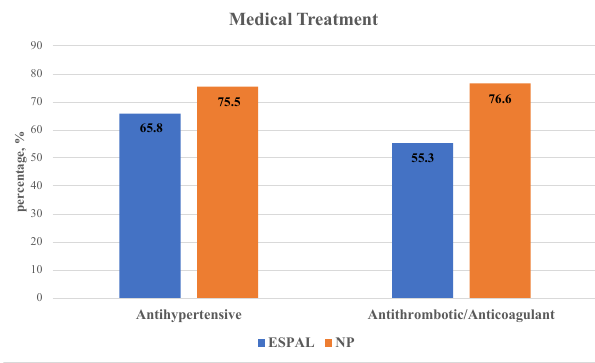
Figure 1. Patients treated with ESPAL or NP in current medical treatment. Antihypertensive and/or antithrombotic/anticoagulants.